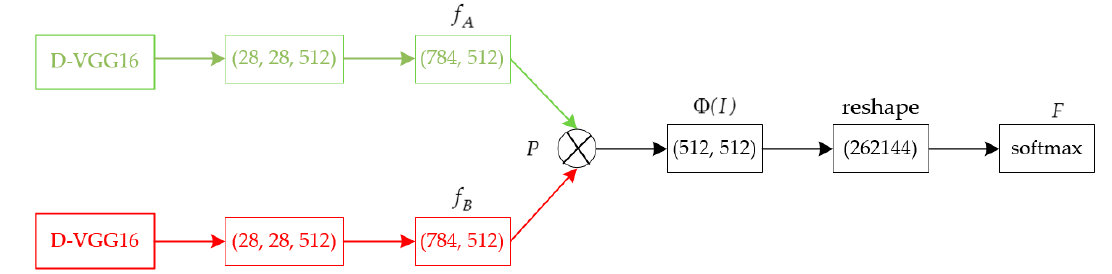
Figure 3. Data stream of the bilinear model.